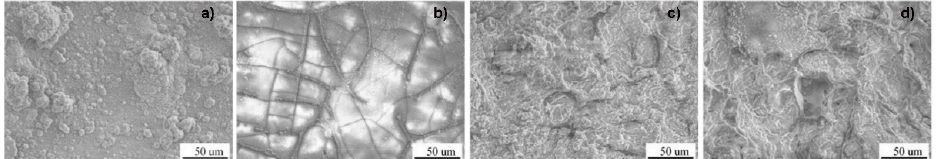
Figure 9. Morphological aspect of some Mg–Ca–Zn biodegradable alloys immersed in a NaCl solution for 24 h: ( a ) Mg–0.8Ca; ( b ) Mg–0.8Ca–1.7Zn; ( c ) Mg–0.8–4.6Zn; ( d ) Mg–0.8–7.5Zn [37].